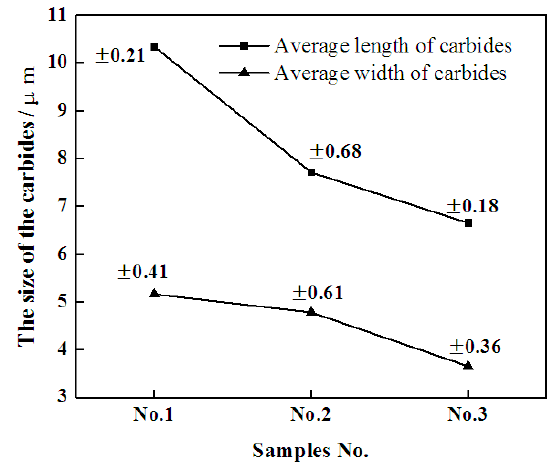
Figure 4. Statistical result of carbides in three samples with different titanium content: values above each point were the standard deviation for each statistic. Metals 2016 , 6 , 193